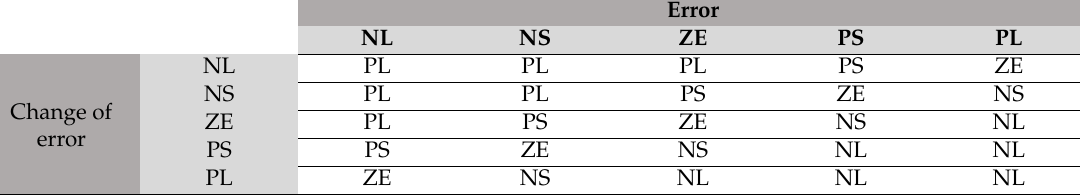
Table 2. Fuzzy law rules used for the rotational